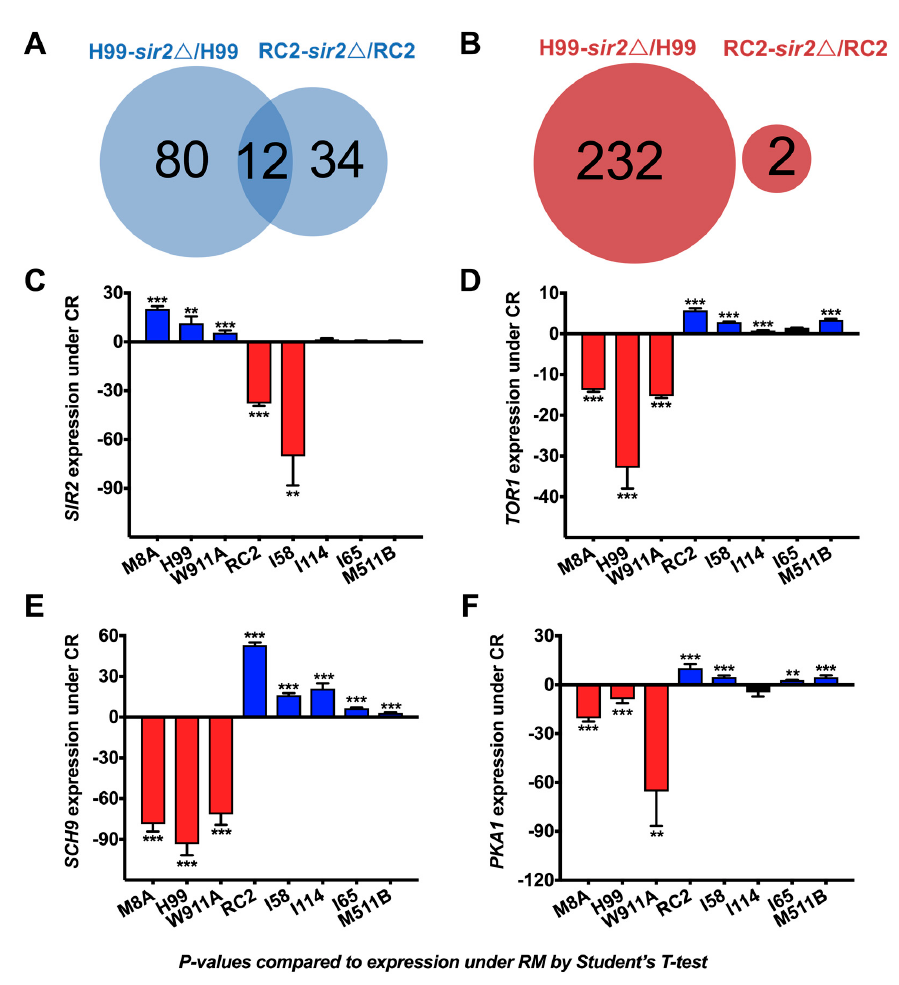
Figure 4. Genes were differentially regulated in C. neoformans strains grown under calorie restriction. Transcriptome analysis of genes regulated under SIR2 for strains grown in CR revealed that ( A ) 10.5% (12 out of 114) upregulated genes were common to strains H99 and RC2, and ( B ) 0% (0 out of 234) downregulated genes were common to strains H99 and RC2. RT-PCR analysis of several C.